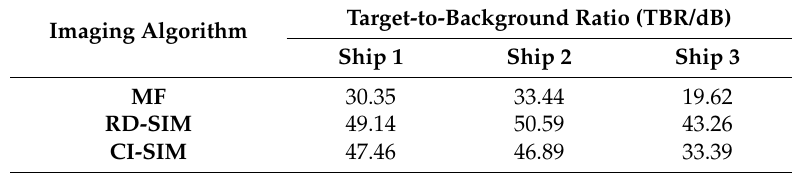
Table 1. Target-to-background ratio (TBR) of target area via different methods with down-sampled data.